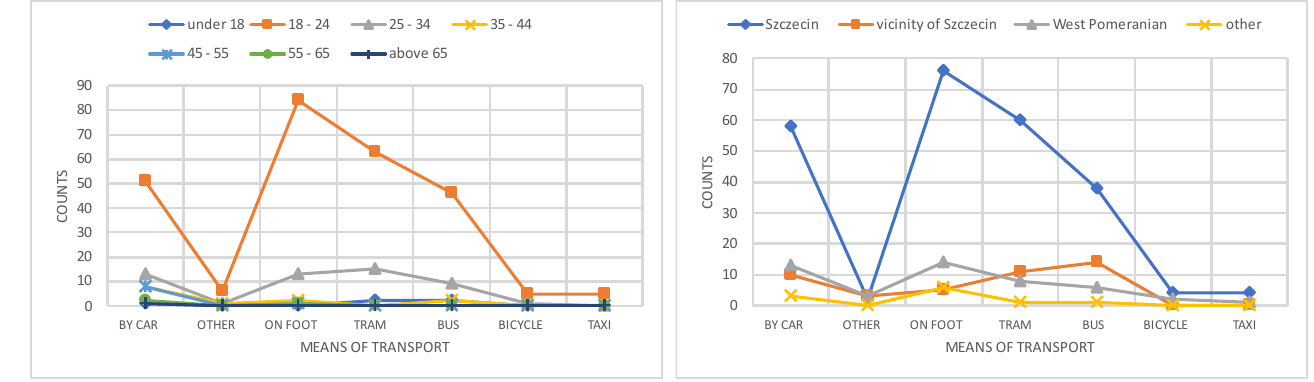
Figure 5. The choice of individual means of transport in the home – school direction.